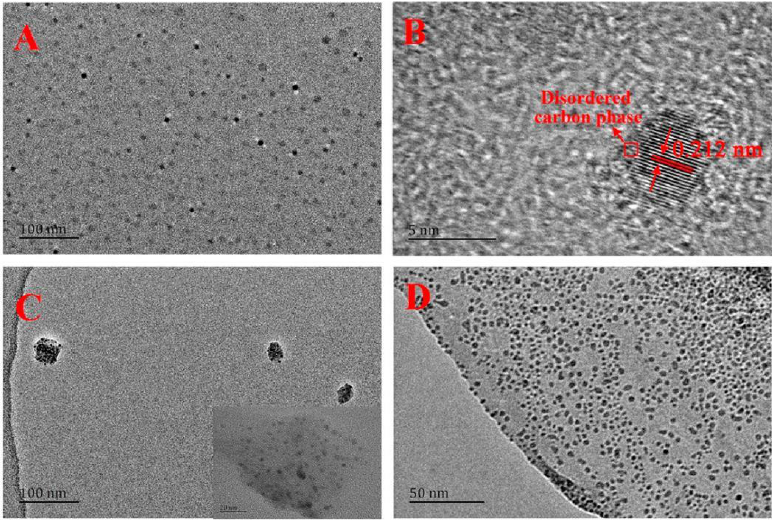
Figure 5. HRTEM image of BD-CDs ( A , B ) in ethanol, ( C ) after adding Al 3+ in ethanol, ( D ) in water. Adapted with permission from Rao et al., 2020, copyright 2020. Reproduced with permission from American Chemical Society [45].